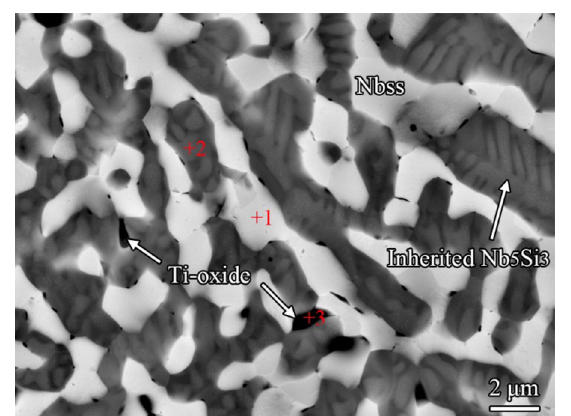
Figure 5 BSE image of the hypereutectic Nb-Si based alloy via EBSM after annealing treatment at 1450 °C for 5 h ( positions for EDS